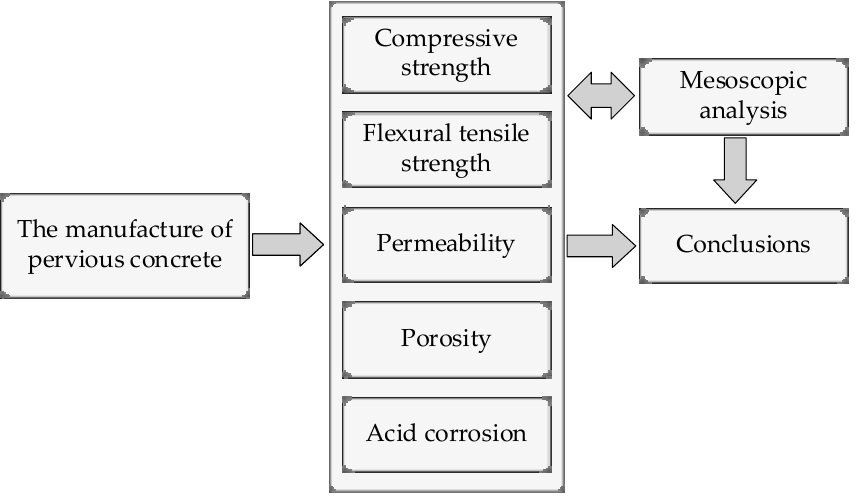
Figure 1. The flow chart of methodology.